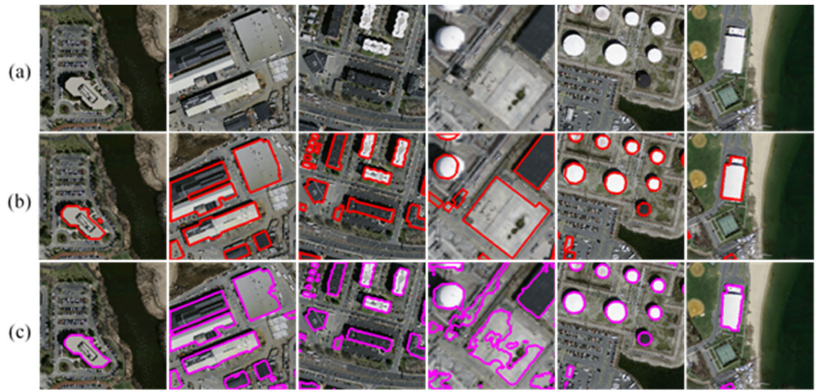
Figure 13. Results of building edge extraction on the Massachusetts dataset. ( a ) Images. ( b ) Labels. ( c )